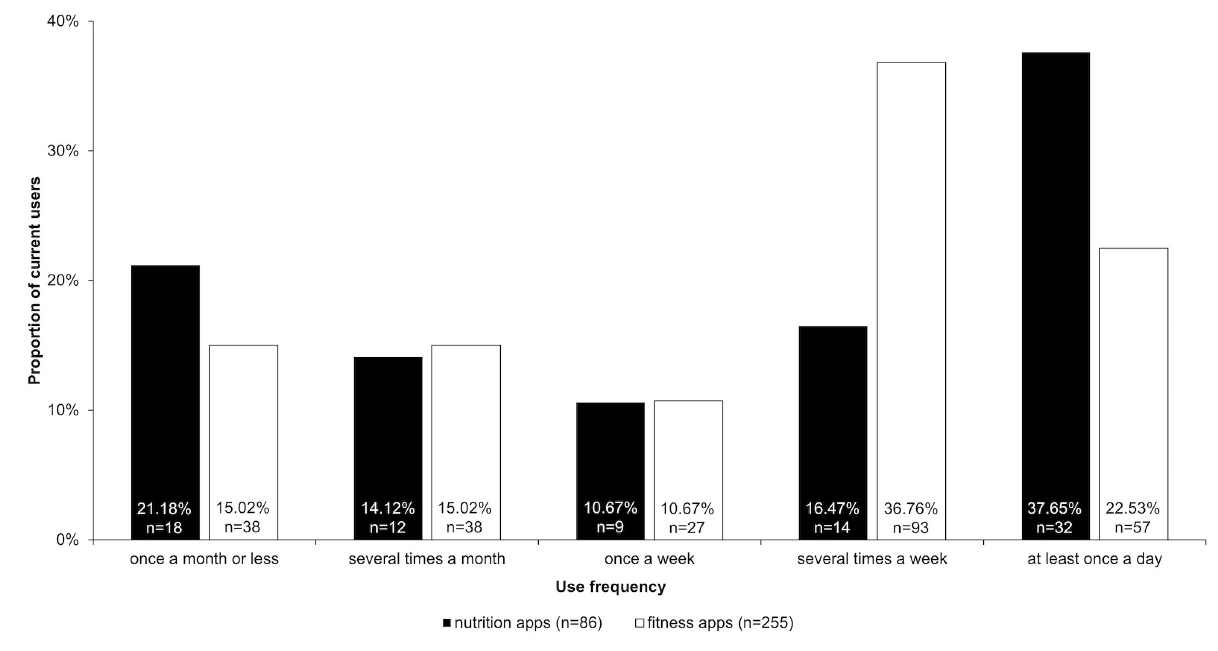
Figure 2. Frequency of use of nutrition (n=86) and fitness apps (n=255).